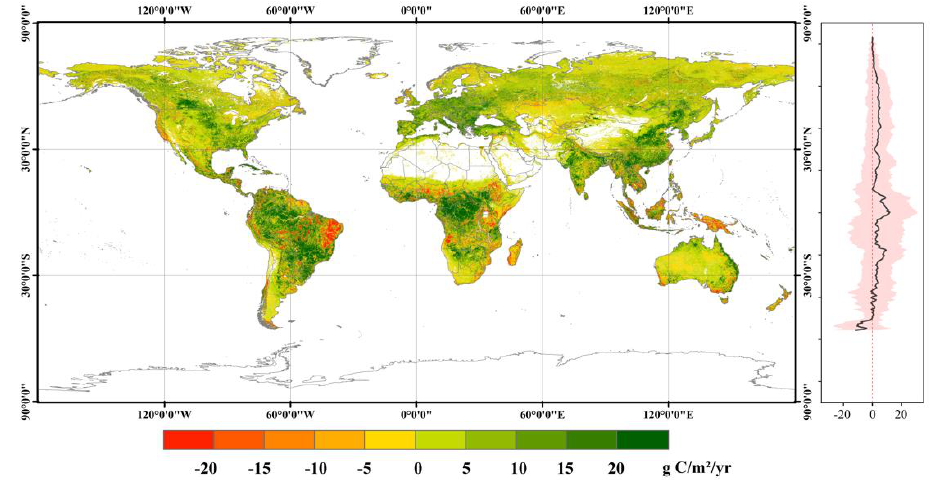
Figure 8. Spatial pattern of interannual variation trend of global GPP estimated by the NI-LUE model from 2001 to 2018.